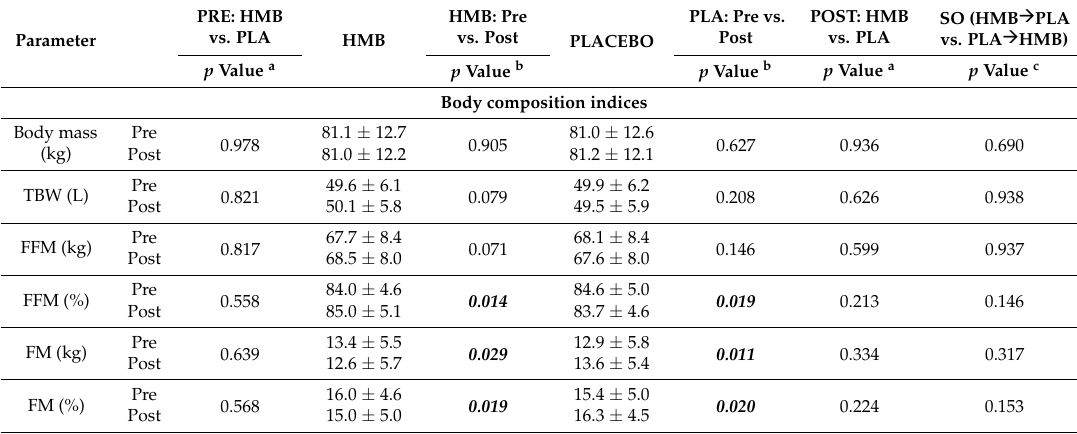
Table 2. Body mass and body composition indices before and after the 12-week supplementation with HMB and placebo preparation.